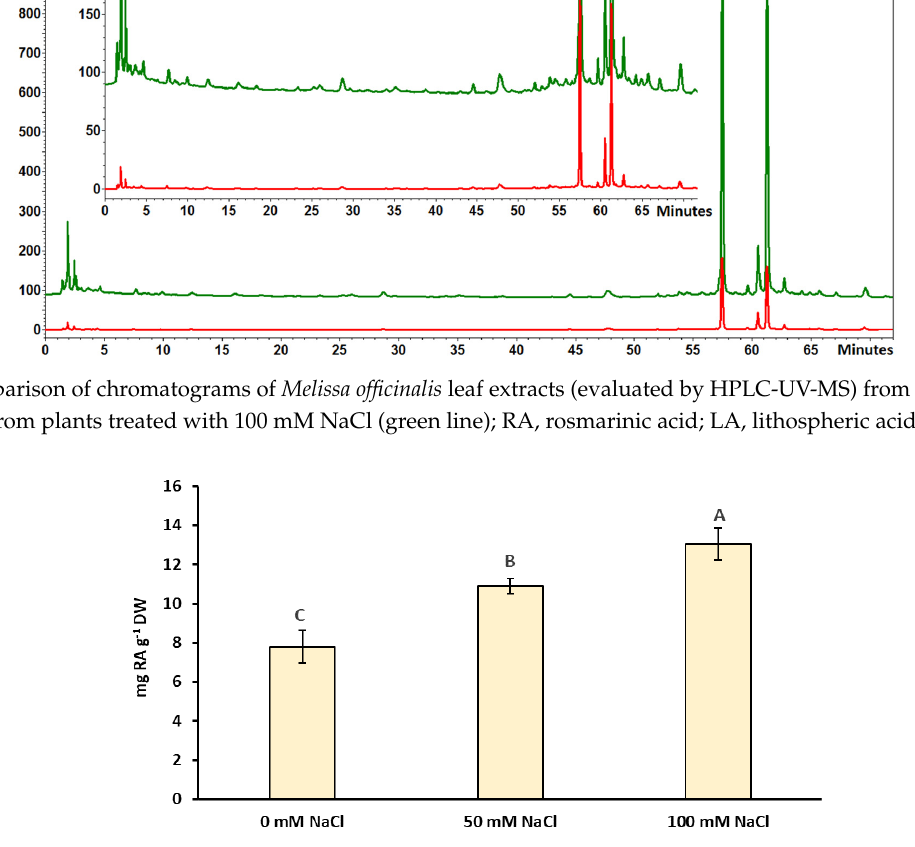
Figure 5. Effect of the NaCl application on the concentration of rosmarinic acid in Melissa officinalis shoots after 10 days of exposure. Data are means ± SD ( n = 4). Means followed by different letters differ statistically significantly ( p < 0.05, Tukey’s test).